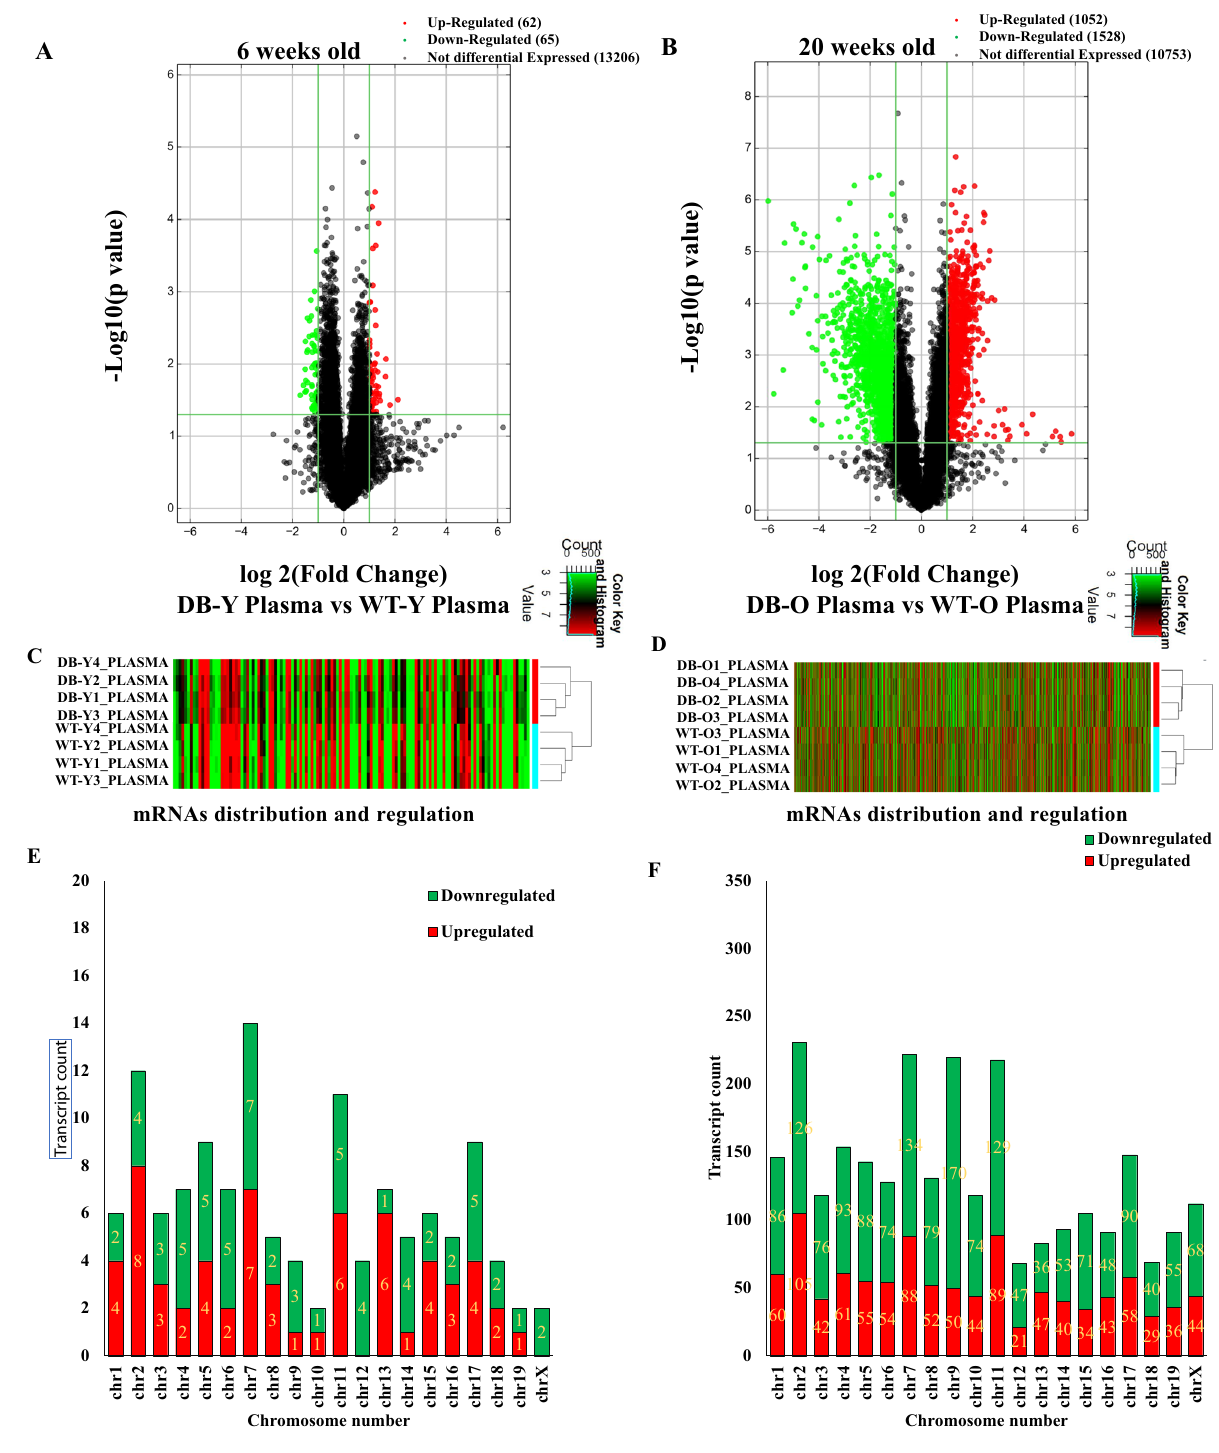
Figure 3. Differential expression Profile of circulating mRNA in db/db mice with and without early diabetic cardiomyopathy compared with controls. (A,B) Volcano plots showing deregulated mRNAs in db/db mice at 6 and 20 weeks of age, respectively compared with age-matched controls. The red and green points represented up- and down-regulated mRNAs, respectively. The horizontal green line depicts *P ≤ 0.05, whereas the vertical green line shows a twofold change of up and down. (C,D) Hierarchical clustering analysis demonstrating differently expressed mRNAs between 6 and 20-week-old db/db mice and controls, respectively. Colors of red and green represented up- and down-regulated mRNAs with changes larger than twofold, respectively. (E,F) Chromosomal distribution of deregulated circulating mRNAs in 6 and 20-week-old db/db mice, respectively. Colors of green and orange represented up- and down-regulated